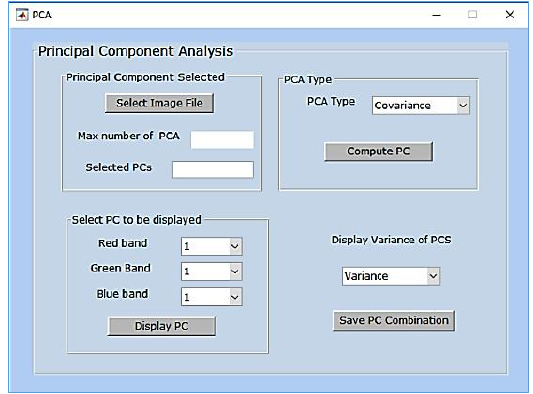
Figure 7. The interface of the PCA sub-module of the classification module of the HICF package.